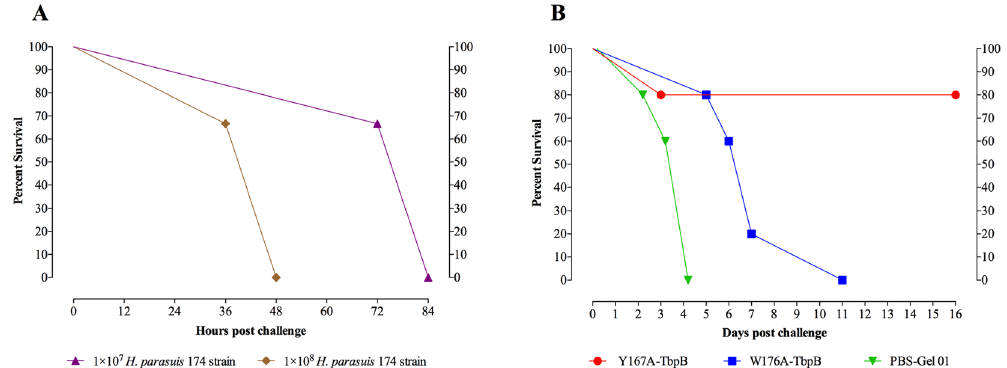
Figure 8. Survival rates of pigs challenged with H. parasuis 174 strain. ( A ) Evaluation of two dose of H. parasuis 174 strain [1 × 10 7 ( n = 3) or 1 × 10 8 ( n = 3)] in conventional pigs. ( B ) Comparative capacity of 2 experimental vaccines to induce a protective immune response against H. parasuis infection. Groups of pigs were immunized with PBS-Gel 01 (control), Y167A-TbpB and W176A-TbpB. The pigs were challenged by intratracheal inoculation with 1 × 10 7 H. parasuis 174 strain and were monitored for clinical signs and symptoms throughout the duration of the experiment, which was 16